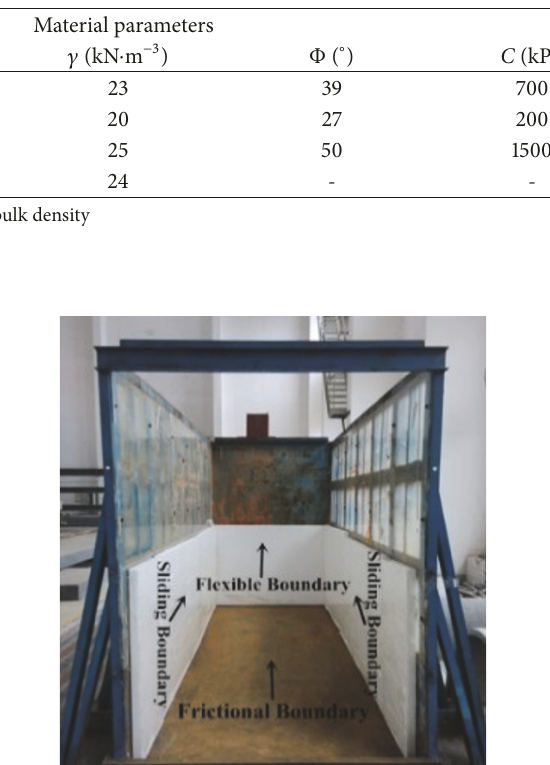
Table 3: Physical and mechanical parameters.